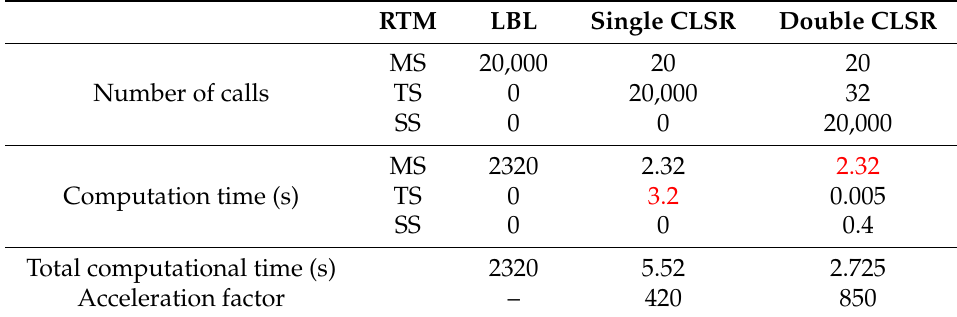
Table 3. Same as for Table 2 but for the O 2 A- and CO 2 bands.